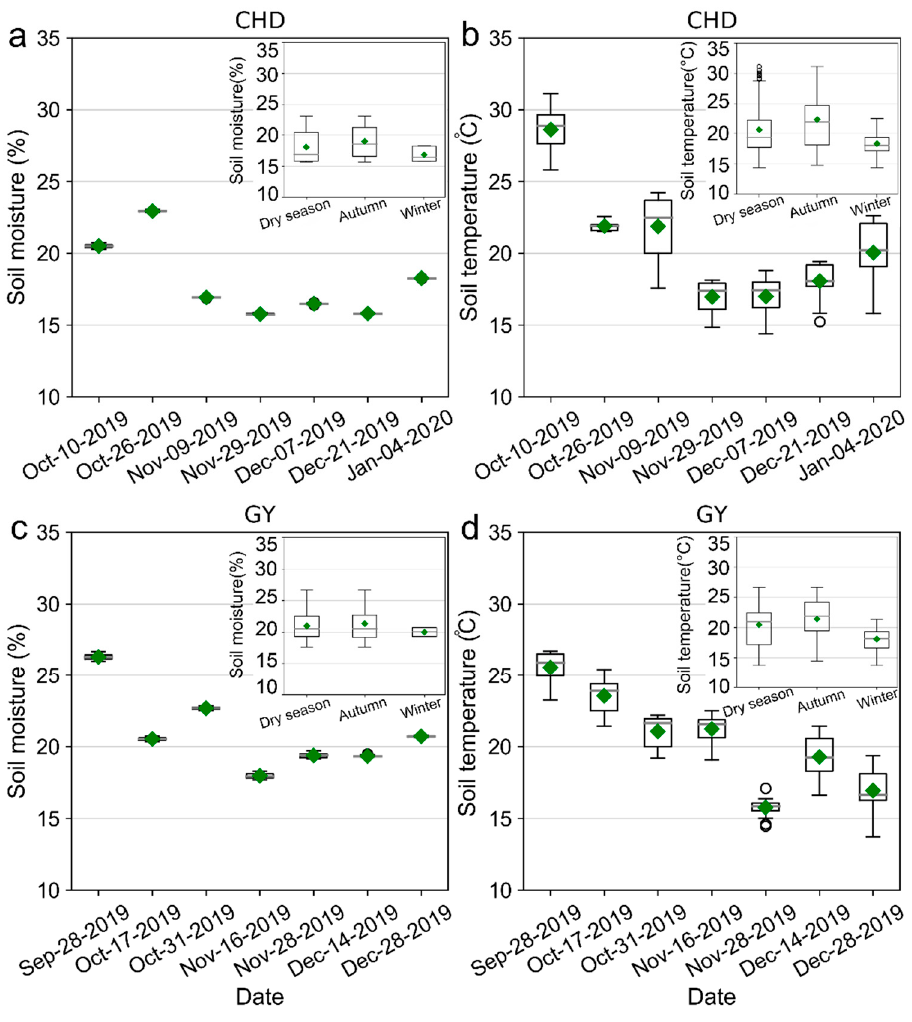
Figure 3. Temporal variations of the SM and ST in CHD ( a , b ) and GY ( c , d ), respectively. The embedded figures are based on summarized values of the SM and ST for the whole dry season, autumn, and winter, respectively. The green quadrilateral represents the average, the gray line in the boxplot is the median, and the black circles are outliers.